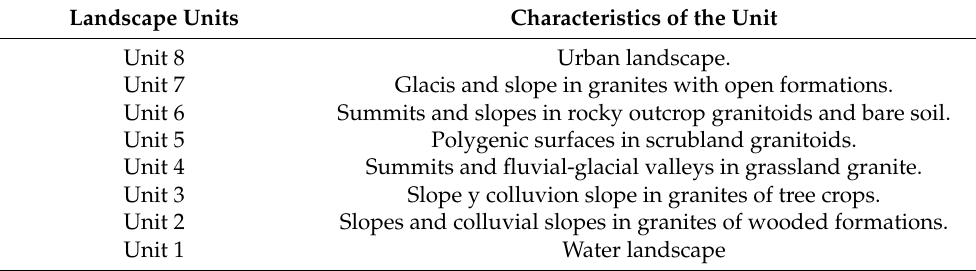
Table 2. Ending landscape unit. Landscape Units